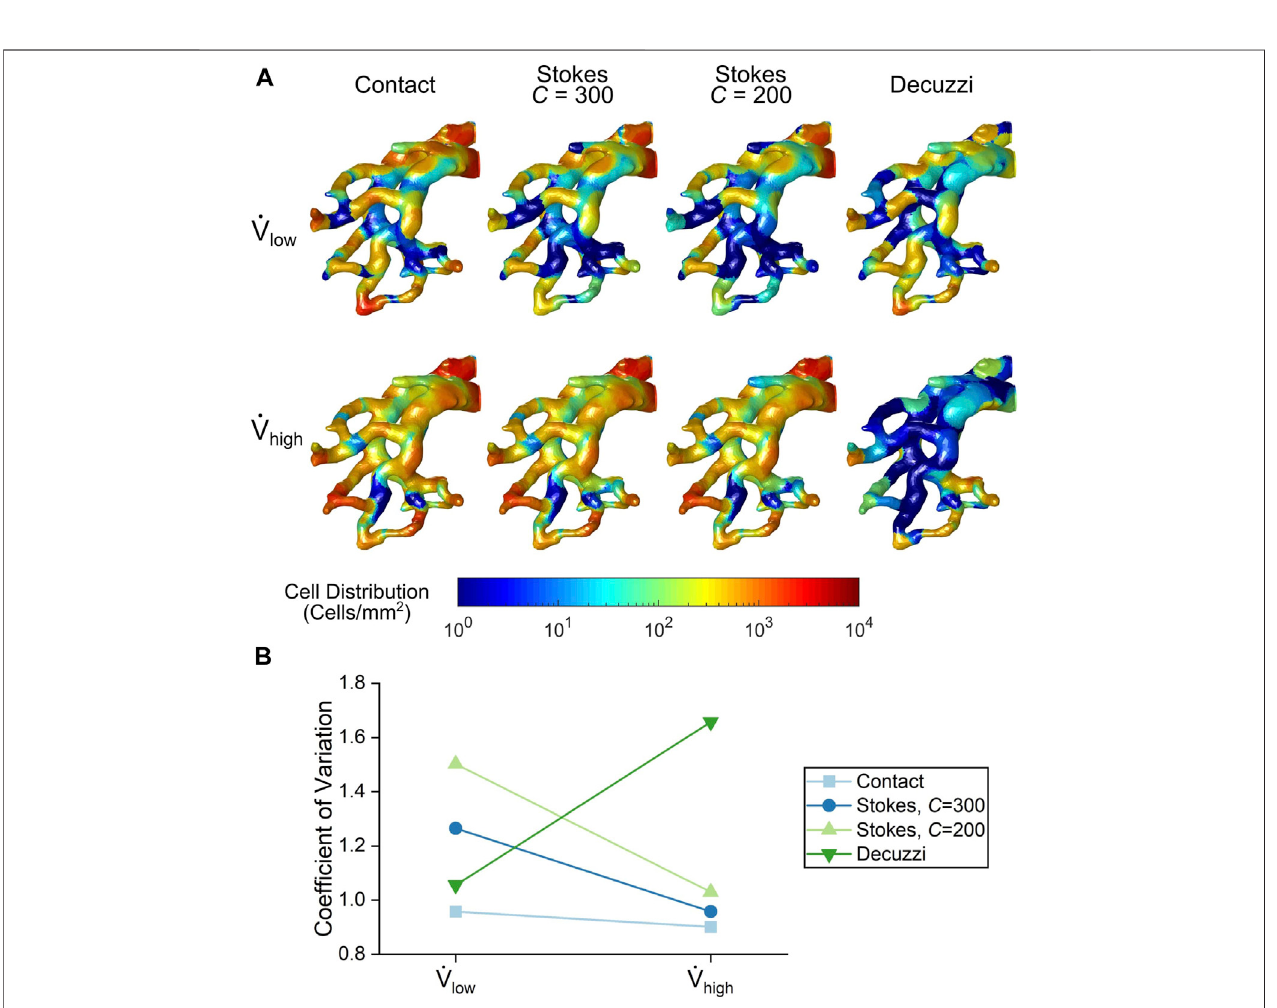
FIGURE 9 | (A) Cell seeding distribution contours from each cell seeding algorithm. (B) Variance quanti fi cation of cell distribution uniformity for each cell seeding algorithm.